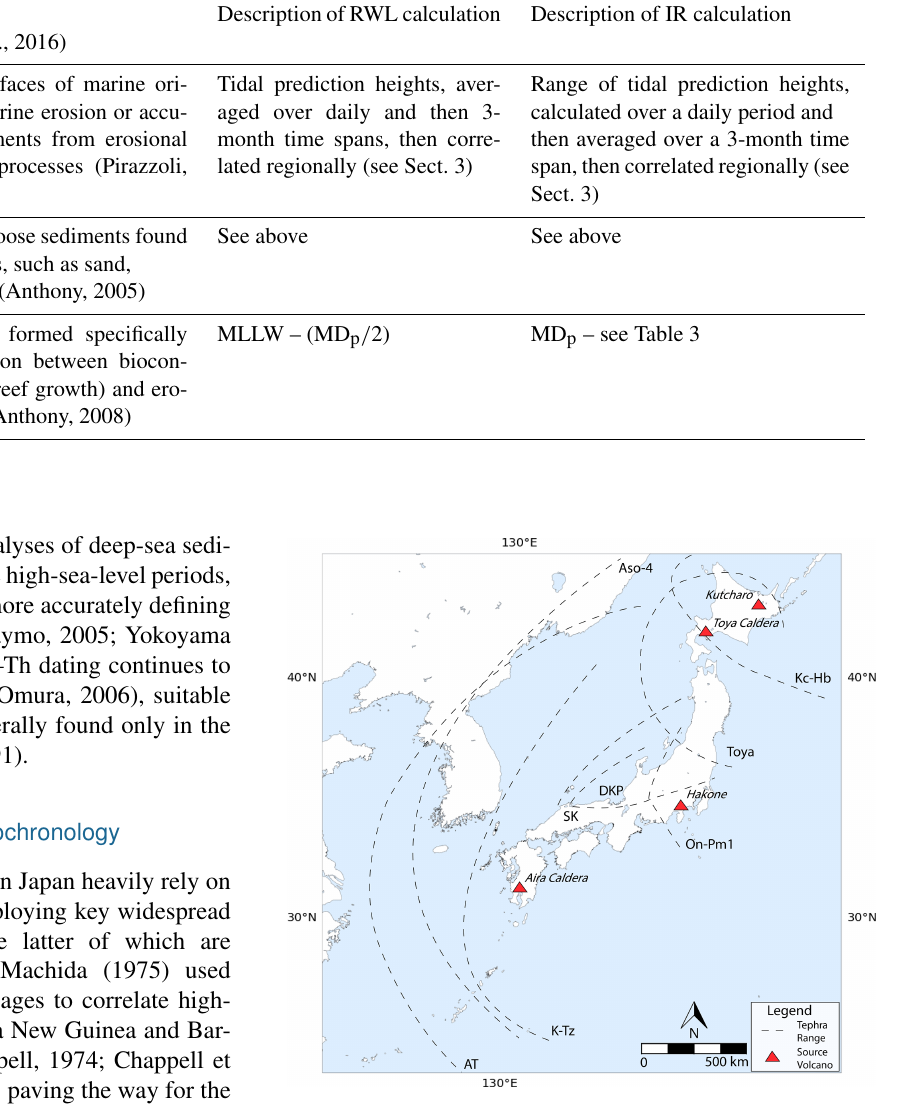
Figure 2. Tephra distribution map in and around Japan, modified from Machida (2002). Tephra recognized as key chronohorizons in this study include Toya, Kc-Hb, On-Pm1, Aso-4, K-Tz, SK, DKP, and AT. Source volcanoes are indicated by red